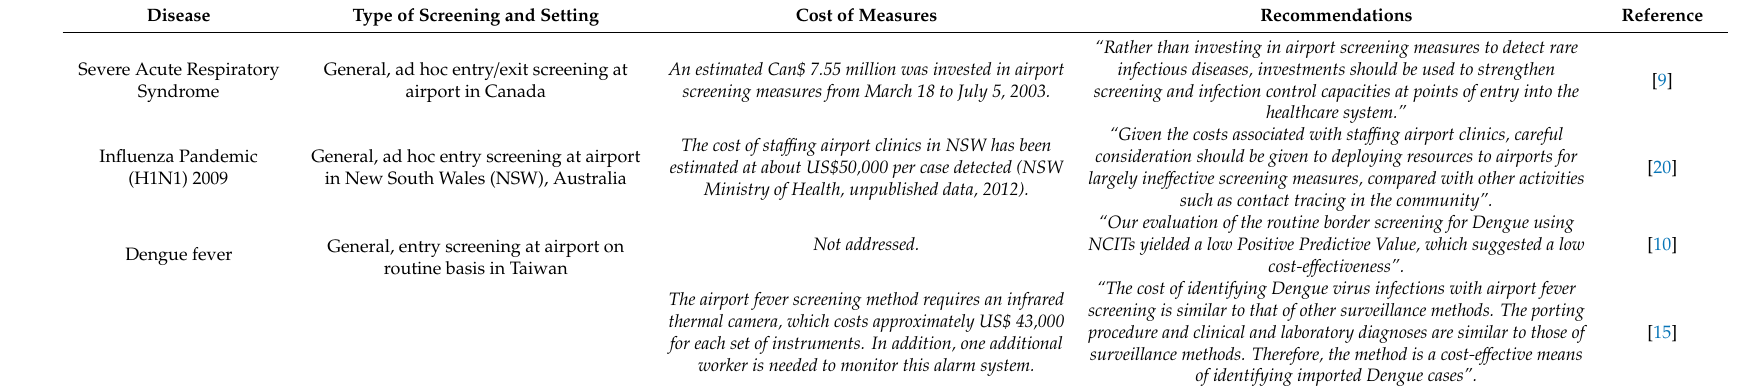
Table 9. Reported facts about the cost of screening